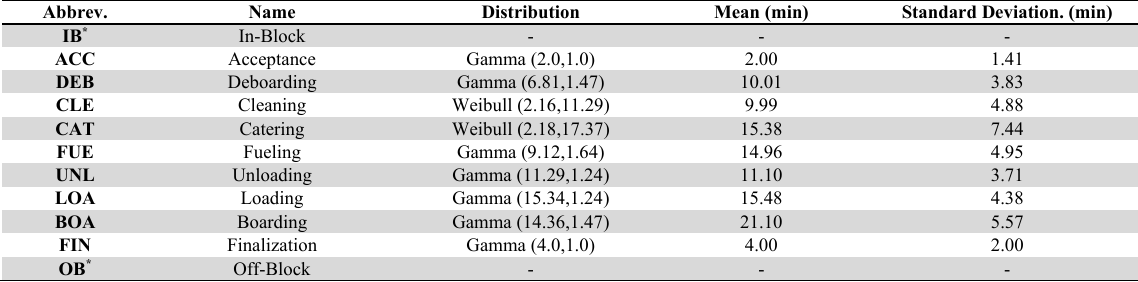
Stochastic turnaround process distribution